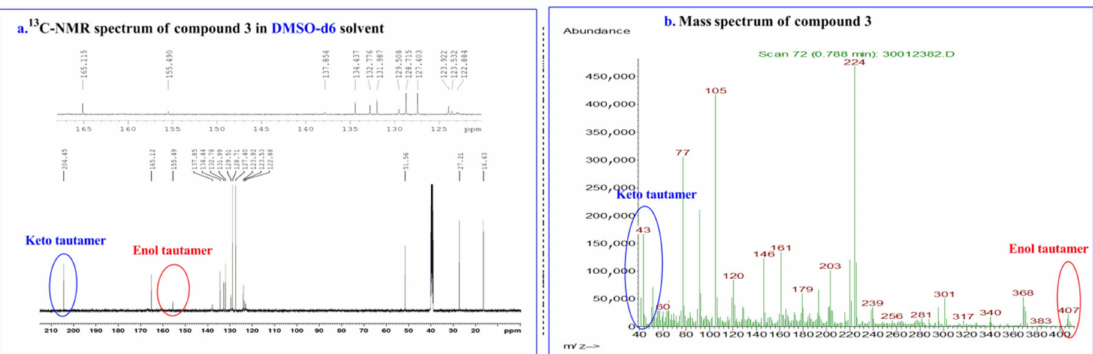
Figure 2. ( a ) 13 C-NMR spectrum of compound 3 in DMSO- d 6 . ( b ) Mass spectrum of Compound 3